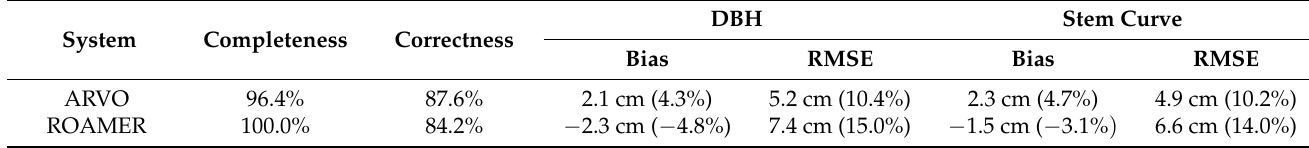
Table 3. Summary of the results regarding tree detection and stem diameter estimations for the ARVO and ROAMER systems. The table provides the completeness and correctness rates of tree detection as well as the bias and RMSE of DBH and stem curve estimates. For the bias and RMSE, we provide the relative value within the parentheses and the absolute value without parentheses. Note that the correctness rate refers to the value without performing any classification of the object